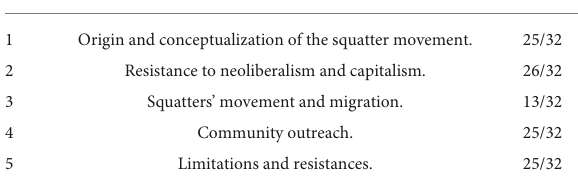
TABLE 3 Categorization and number of articles that mention each category.